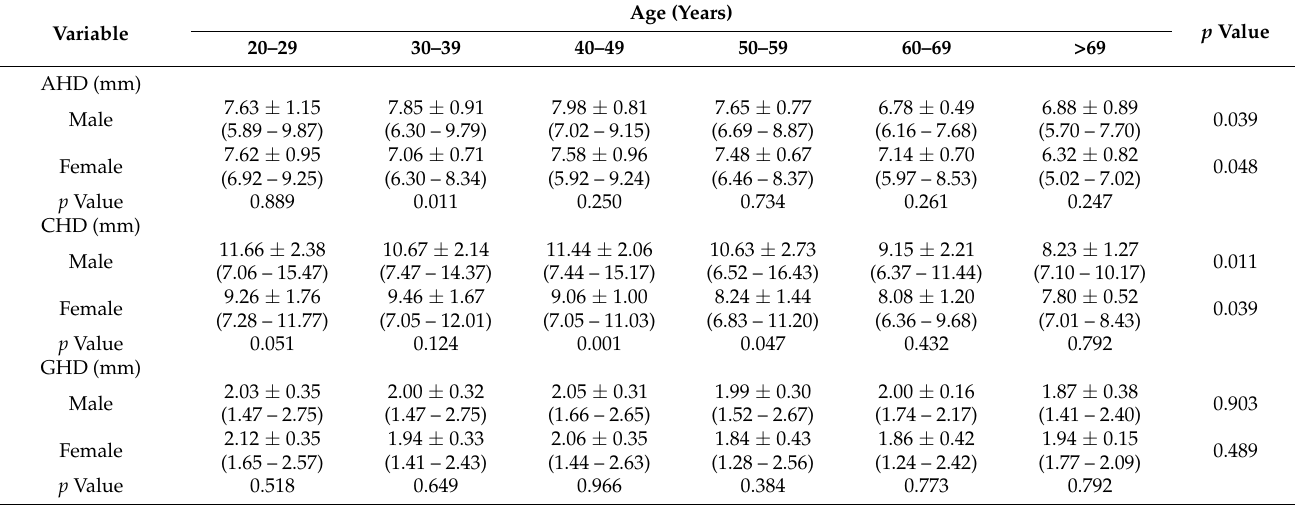
Table 3. AHD, CHD, and GHD statistical analysis between sexes in age